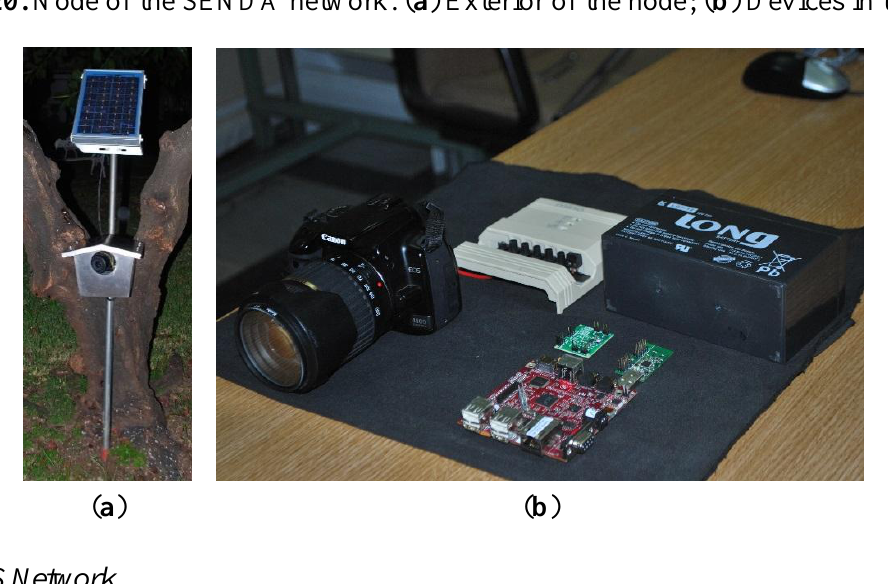
Figure 20. Node of the SENDA network. ( a ) Exterior of the node; ( b ) Devices in the